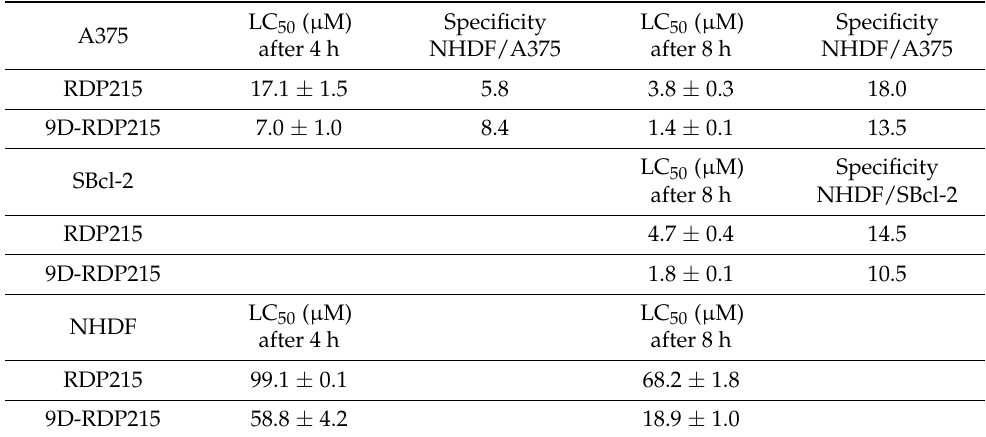
Table 5. A comparison of LC 50 values ( µ M) of the melanoma cell line A375 and normal human dermal fibroblasts NHDF determined by PI-uptake upon 4 and 8 h of peptide treatment. LC 50 ( µ M) A375 after 4